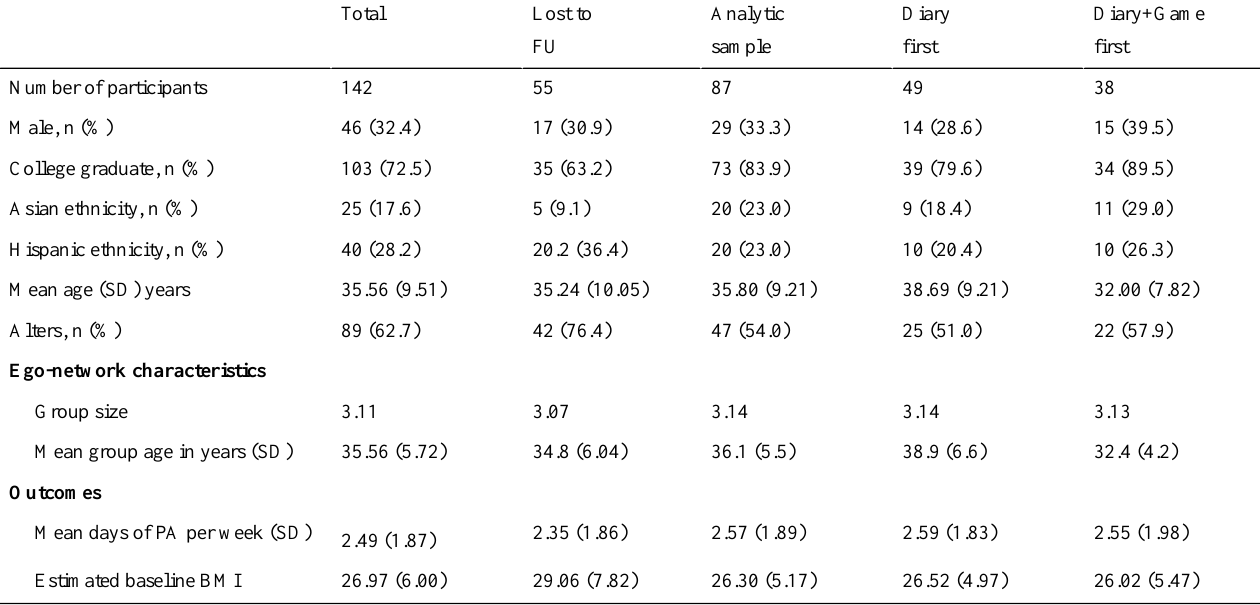
Table 1. Sociodemographic characteristics of study participants by condition.